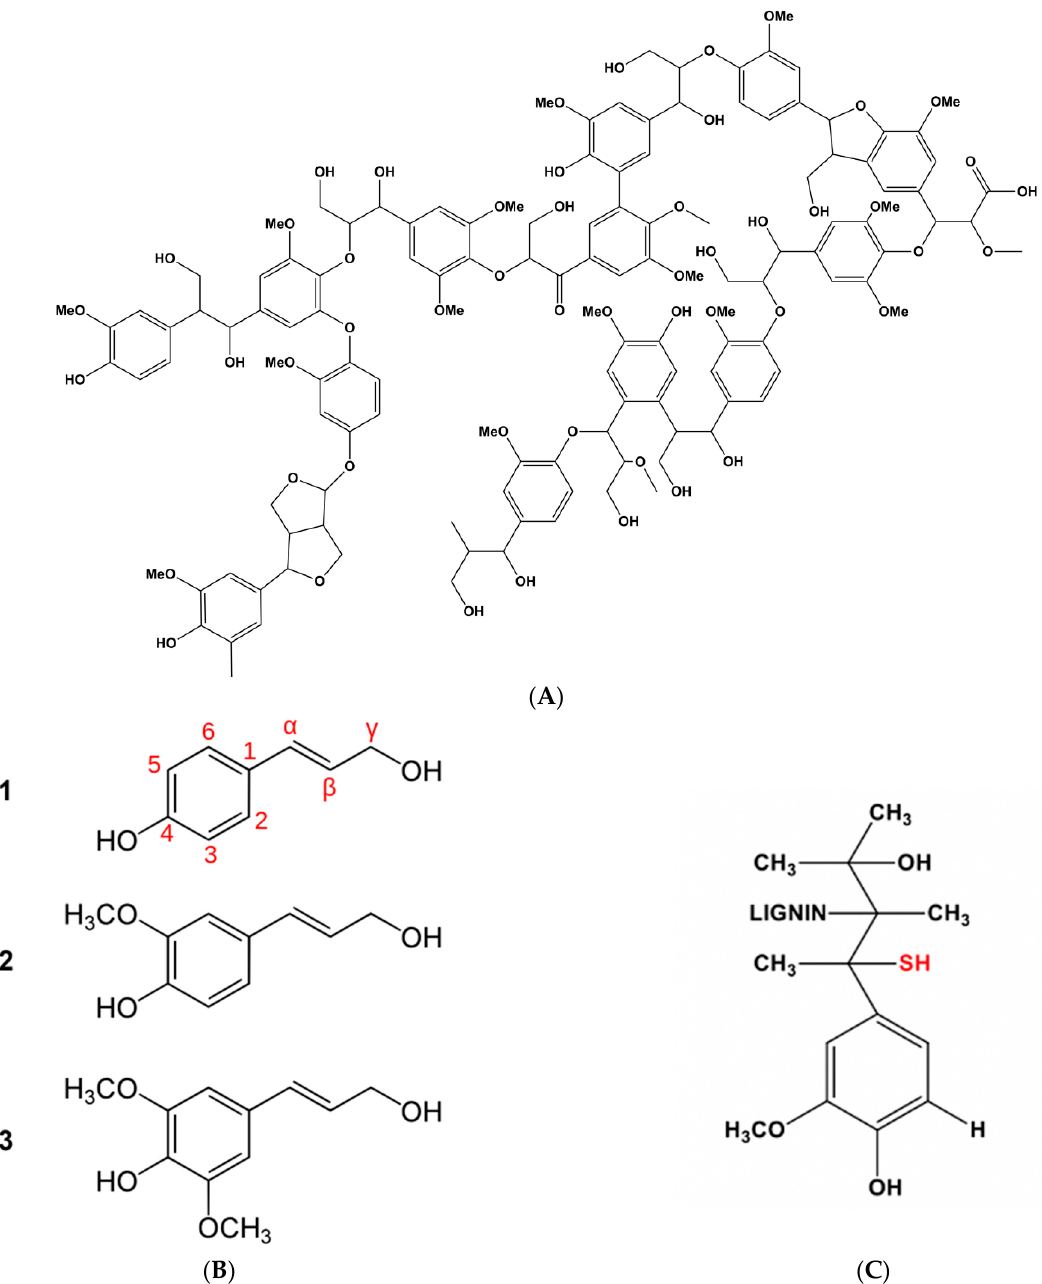
Scheme 1. ( A ) Schematic structure of lignin; ( B ) the three common monolignols: paracoumaryl ( 1 ), coniferyl ( 2 ) and sin- apyl ( 3 ) alcohol; ( C ) chemical structure of kraft lignin